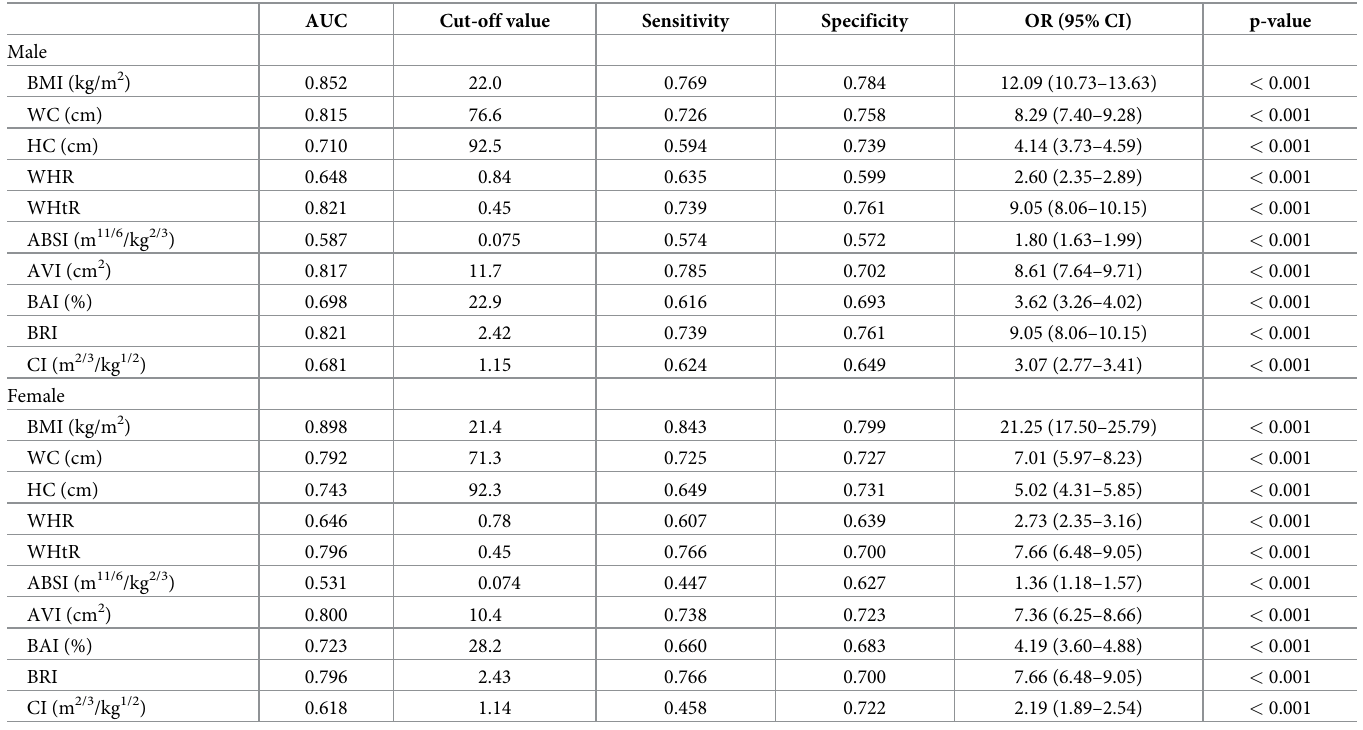
Table 2. AUC, cut-off value, sensitivity, specificity, and odds ratio of anthropometric indices for masked obesity in all